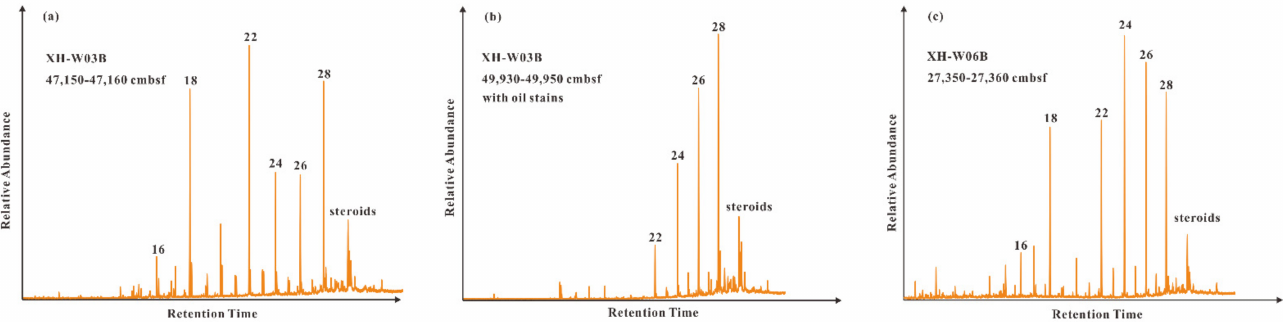
Figure 6. GC-MS chromatograms showing the distribution of n -alkanols and steroids in sediments from ( a , b ) core GMGS4- XH-W03B and ( c ) core GMGS4-XH-W06B. Arabic numerals indicate the numbers of carbon